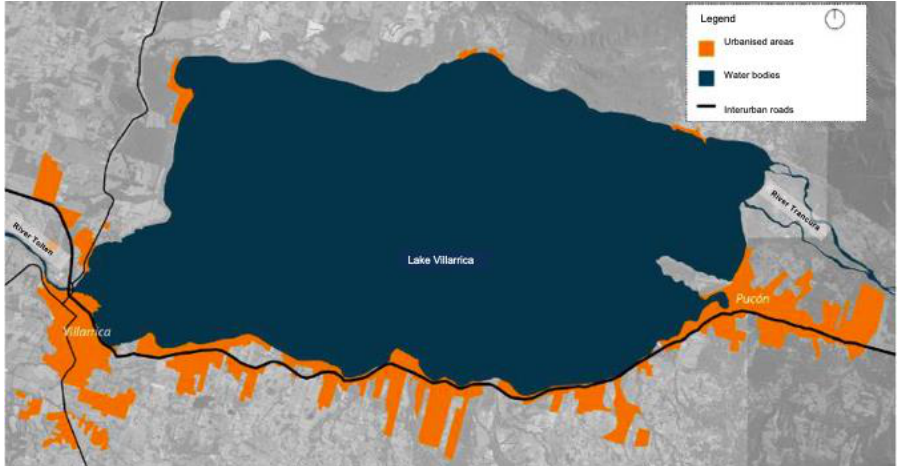
Figure 2. Urban growth through the subdivision of rural land, discounting indigenous lands. Source: Plan Maestro Pucón, 2019.